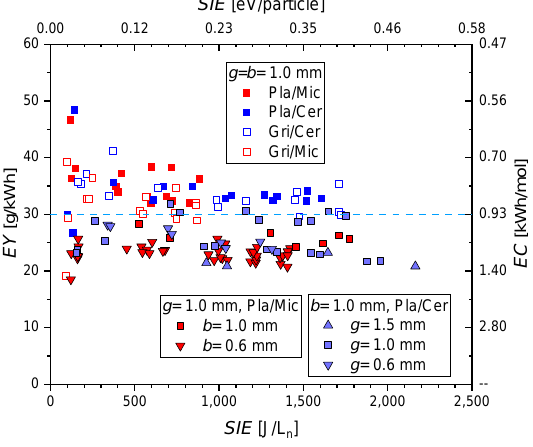
Figure 11. Energy yield and energy cost of CO formation as a function of SIE for the different DBD reactors. The light blue dashed line corresponds to the one in Figure